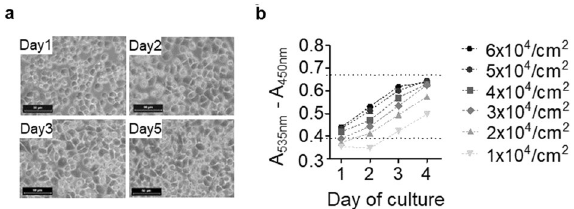
Figure 2. Performance of miniaturized DMMB assays with primary chondrocyte culture. ( a ) Primary chondrocytes from porcine costal cartilage showed polygonal morphology and reached full confluence at Day 5. ( b ) DMMB assay with chondrocytes at different seeding densities (1–6 × 10 4 /cm 2 ) and culture periods. Dotted lines indicate the linear reading range (0.37–0.69). Values are presented as the mean ± SEM. DMMB (n = 5); scale bar, 50 µm.